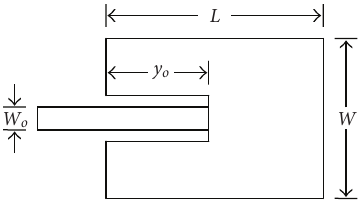
Figure 2: Patch antenna with a line feed.